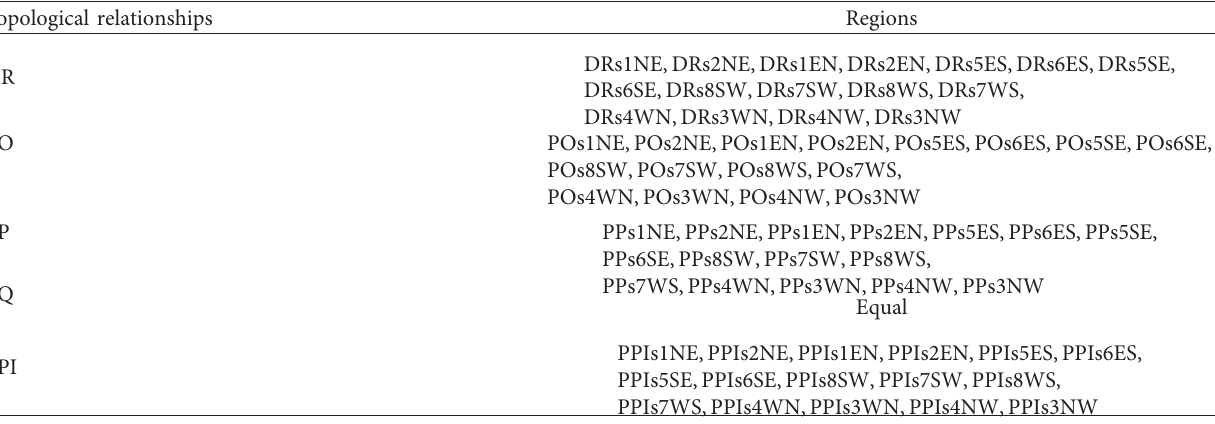
Table 3: The list of all directional and topological relationships.